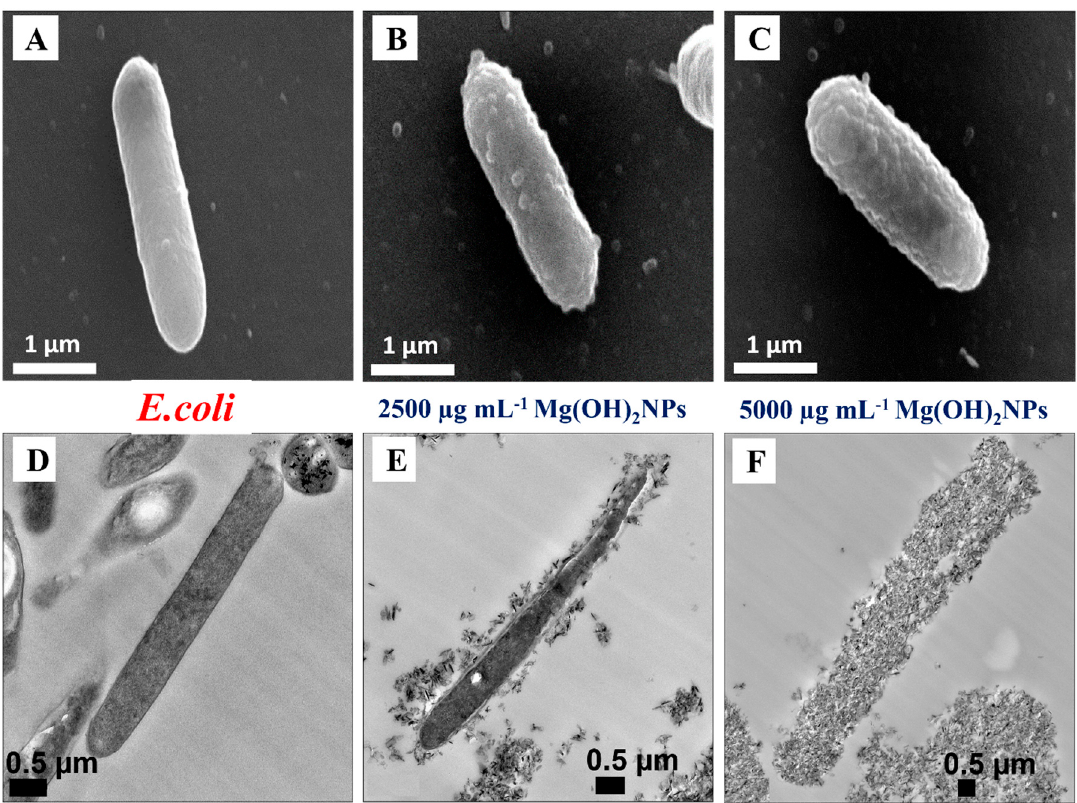
Figure 7. Scanning electron microscopy (SEM) and TEM images of E. coli after being incubated for 24 h with a suspension of bare Mg(OH) 2 NPs: ( A ) SEM and ( D ) TEM images of an untreated sample. ( B ) SEM and (E) TEM images of E. coli incubated with 2500 µg mL − 1 Mg(OH) 2 NPs. ( C ) SEM and ( F ) TEM images of E. coli incubated with 5000 µg mL − 1 Mg(OH) 2 NPs.